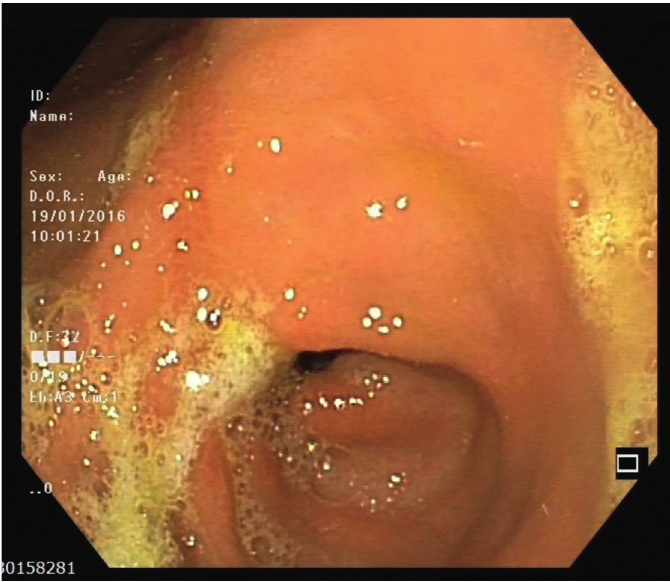
Figure 4: Follow-up endoscopy showing a residual